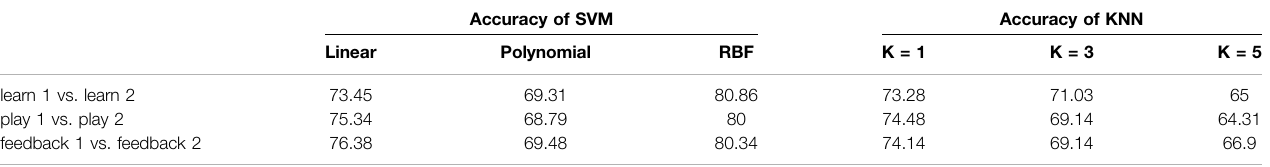
TABLE 3 | Classi fi cation rate in children learn, children play and robot feedback across warm up (S1) and music practice (S2) sessions.